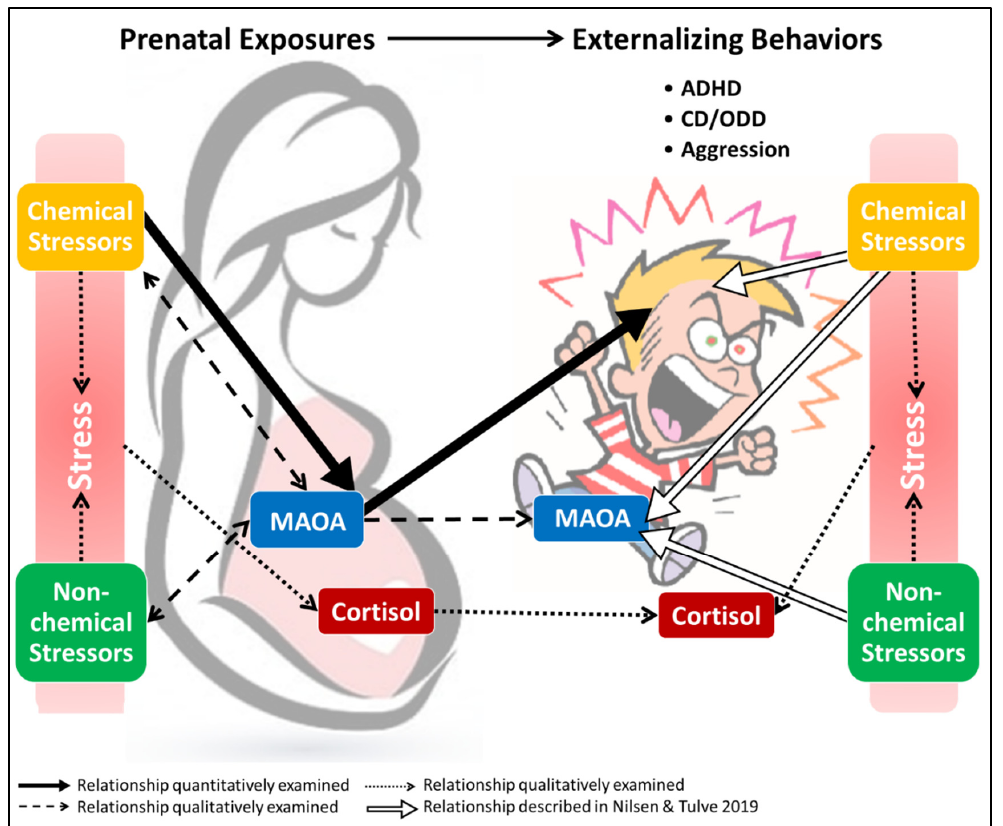
Figure 7. Visual representation depicting the interrelationships between prenatal exposure to chemical and non-chemical stressors, MAOA, cortisol, and their collective influence on children’s externalizing outcomes.